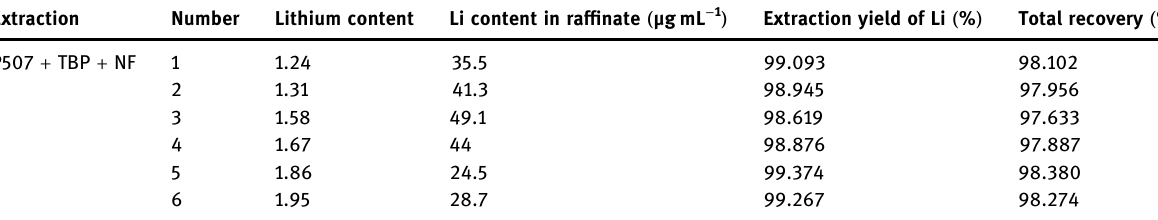
Table 2: The yield of lithium during extraction and lithium total yield